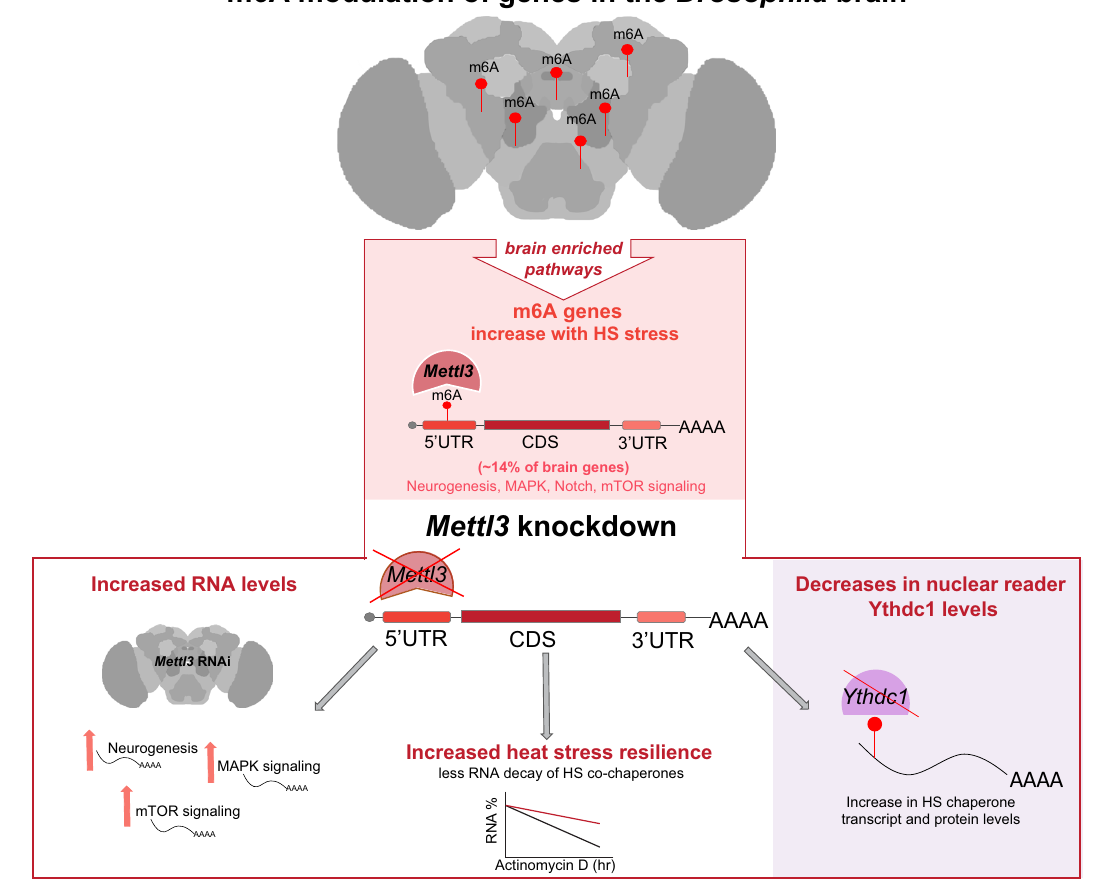
Fig. 8 | m 6 A modulation of genes in the Drosophila brain. Our data indicate a modelwherebym 6 Aisenrichedinthebrainandinthe5 ′ UTRofselecttranscriptsin the Drosophila brain.m 6 Amodi fi cationonpolyA+RNAshowsadynamicincreasein the brain with acute heat stress. Levels of m 6 A modi fi ed gene transcripts that increase with heat stress are enriched for neurogenesis and dynamic signaling pathways. Mettl3 knockdown decreases the level of m 6 A in the 5 ′ UTR of its target